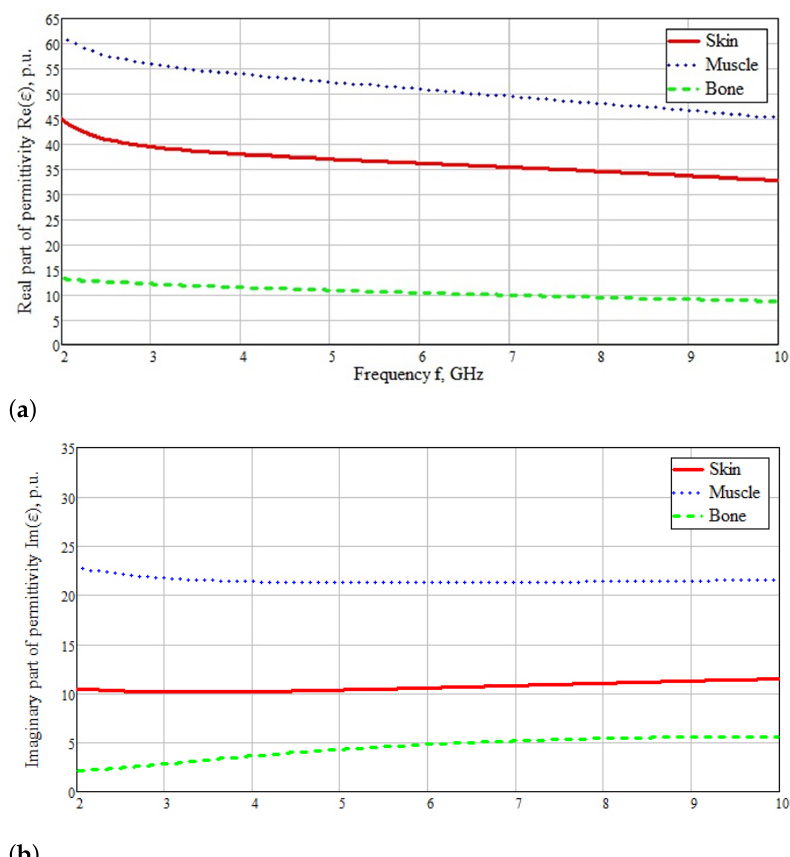
Figure 10. Frequency dependence of the real ( a ) and imaginary ( b ) parts of the relative permittivity of the created biological